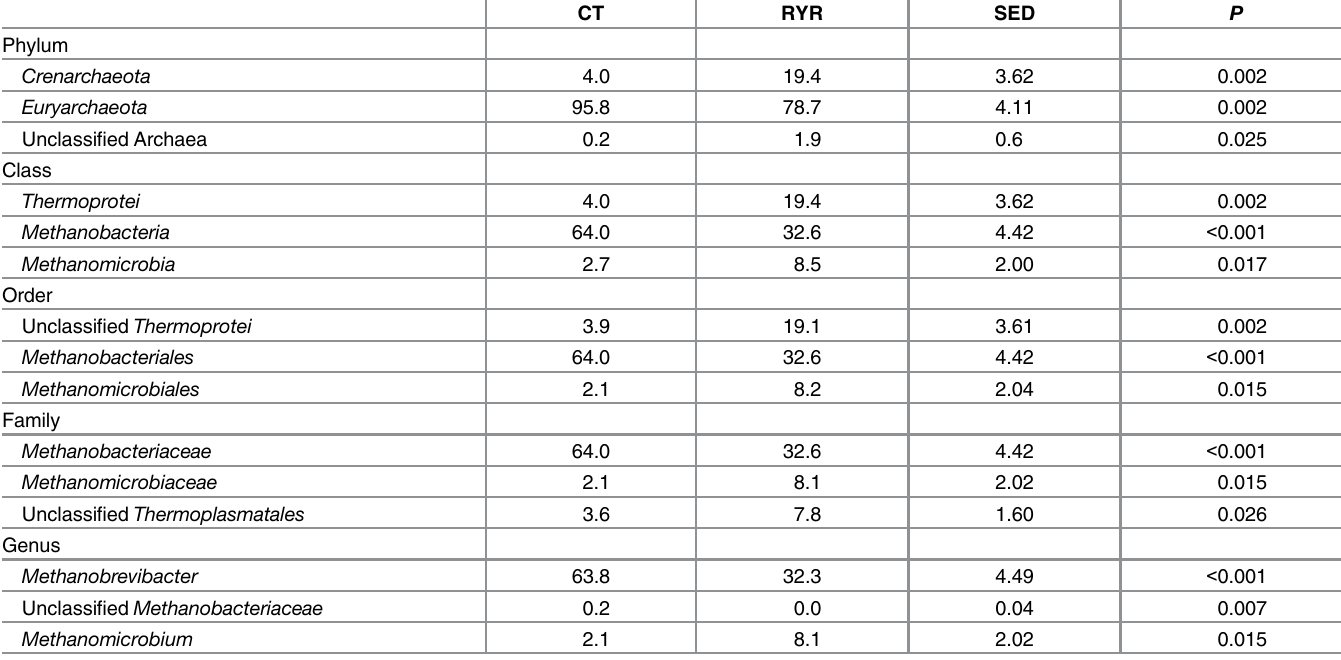
Table 8. The comparison of archaeal abundances from level phylum to level genus in goat rumen between RYR group and CT group (% of sequen- ces) a (n = 20).